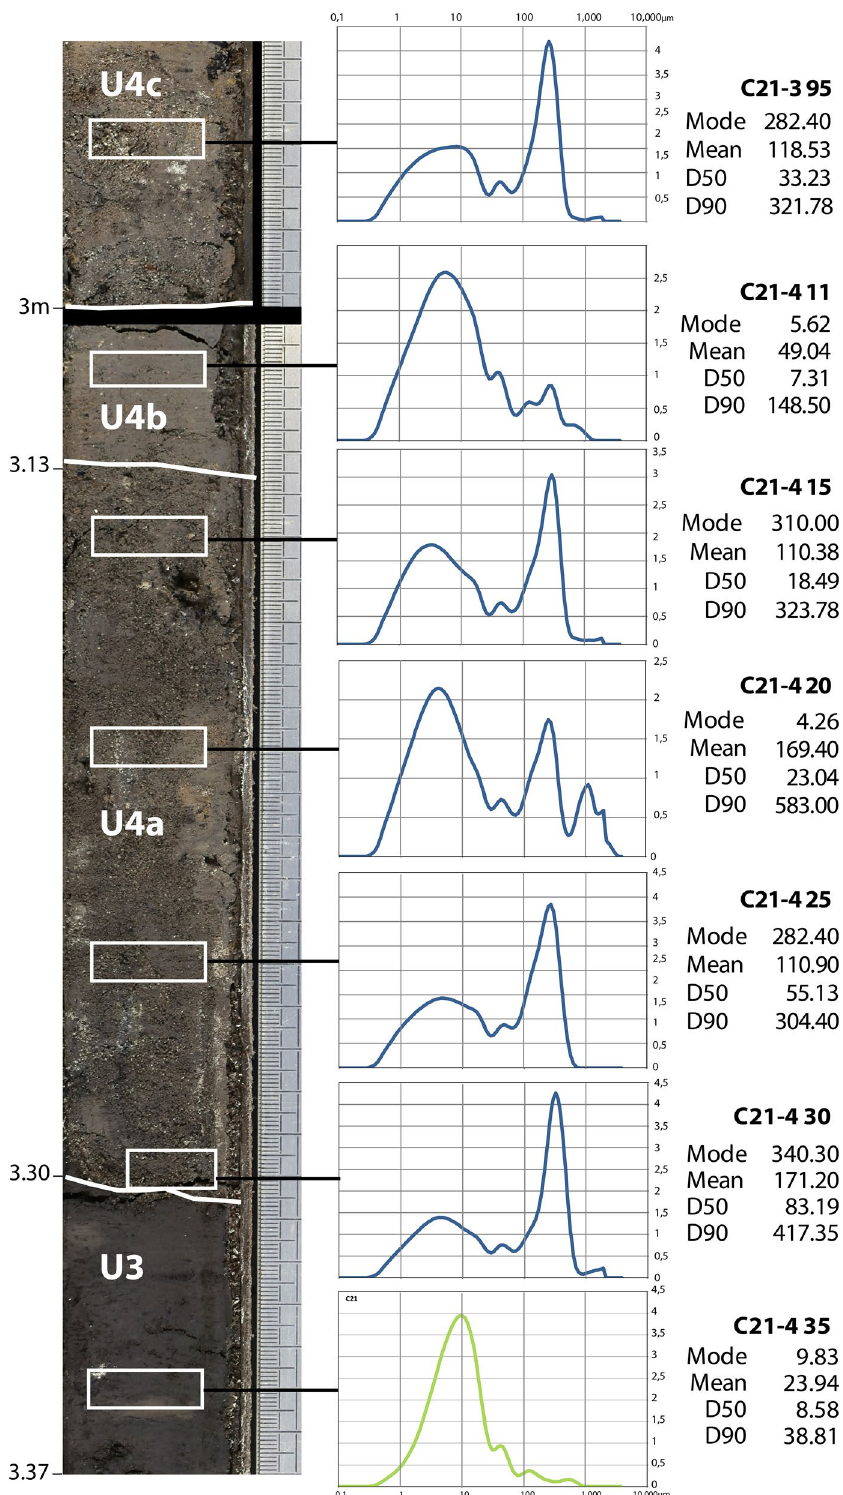
Figure 5. C21 sedimentary facies, grain size distribution and main descriptive statistics of U3 and U4 (high energy deposits). Photographs of C21-4 and base of C21-3 core sections. U3 deposit (in green) are marshy deposits ante-event (vertical depth in m, right-hand scale with elementary unit equal to 1